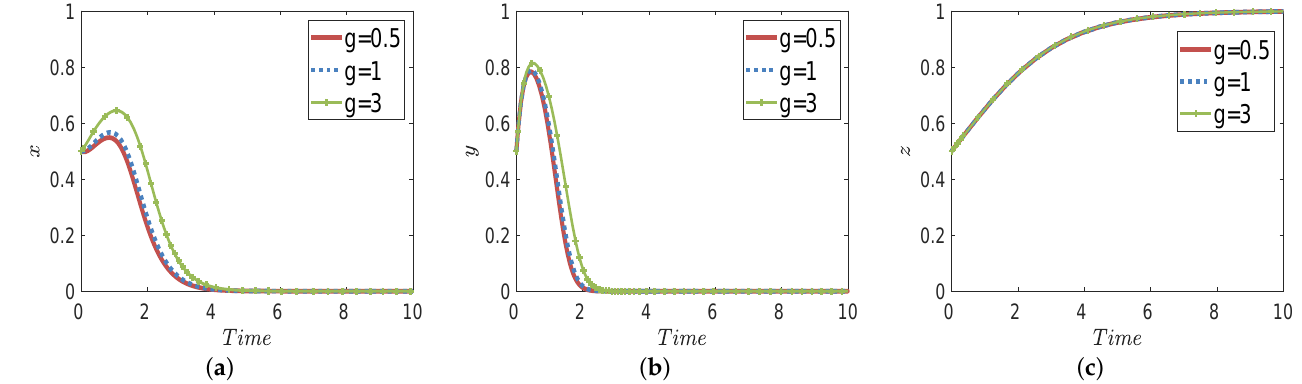
Figure 13. The impact of g on evolution: ( a ) crowd workers; ( b ) crowdsourcing platforms; ( c ) task